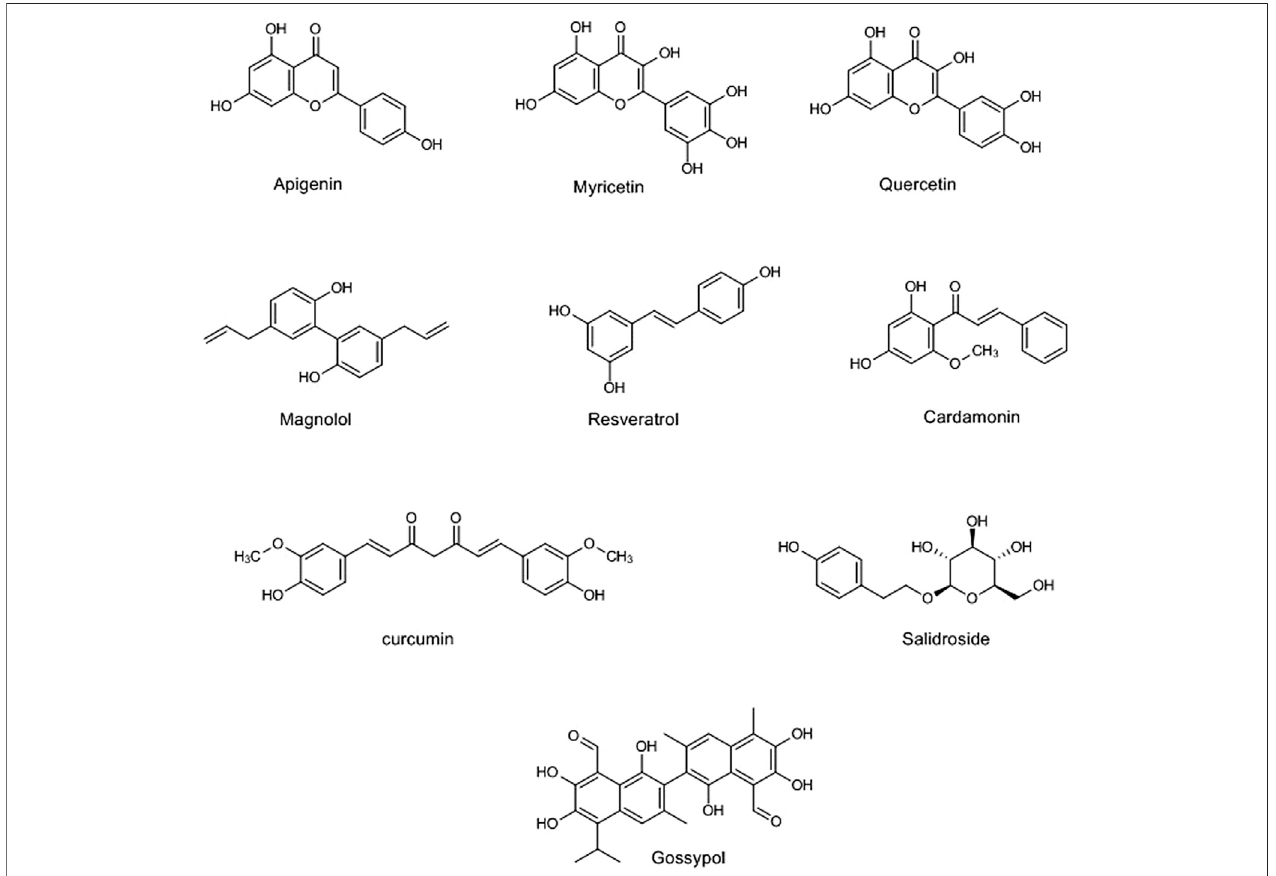
FIGURE 2 | Selected chemical structures of polyphenols with potential protective effects against lung injury.